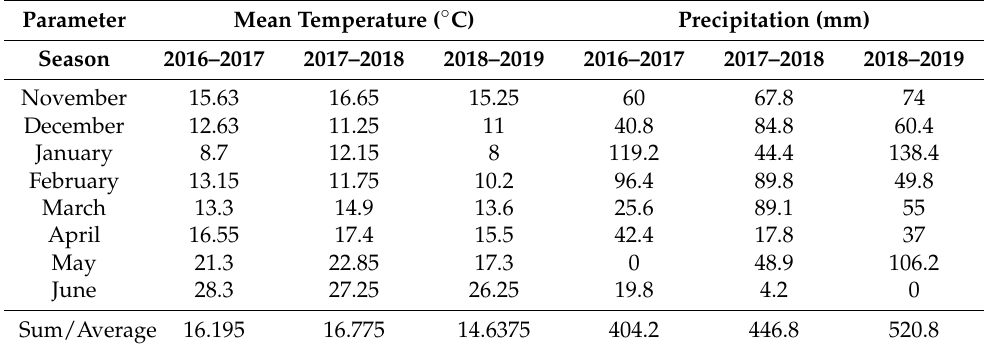
experimental station of Oued Beja.